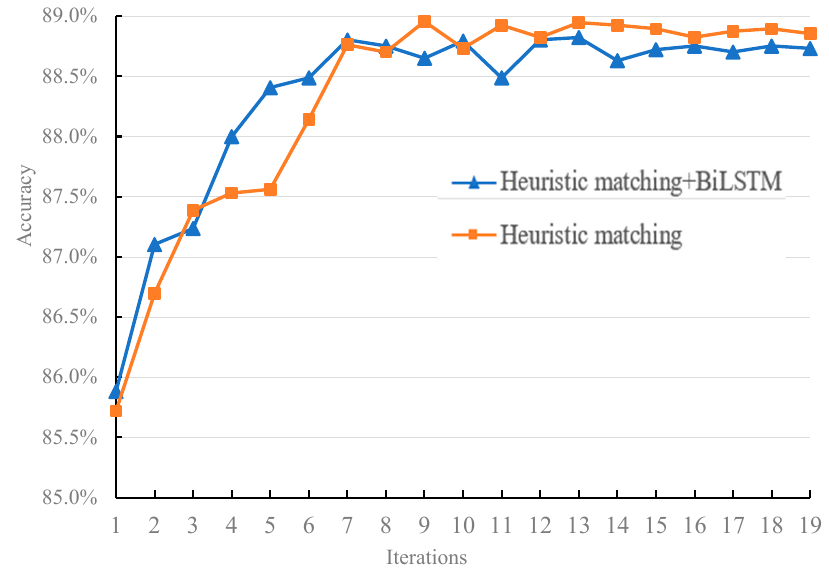
Figure 6. The learning curve of SCF-DMN (different fusion layers) on SNLI.